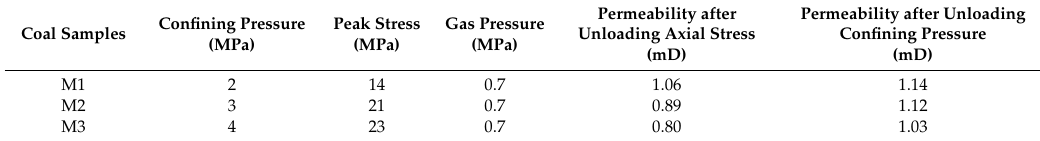
Table 2. The experiment results of the coal